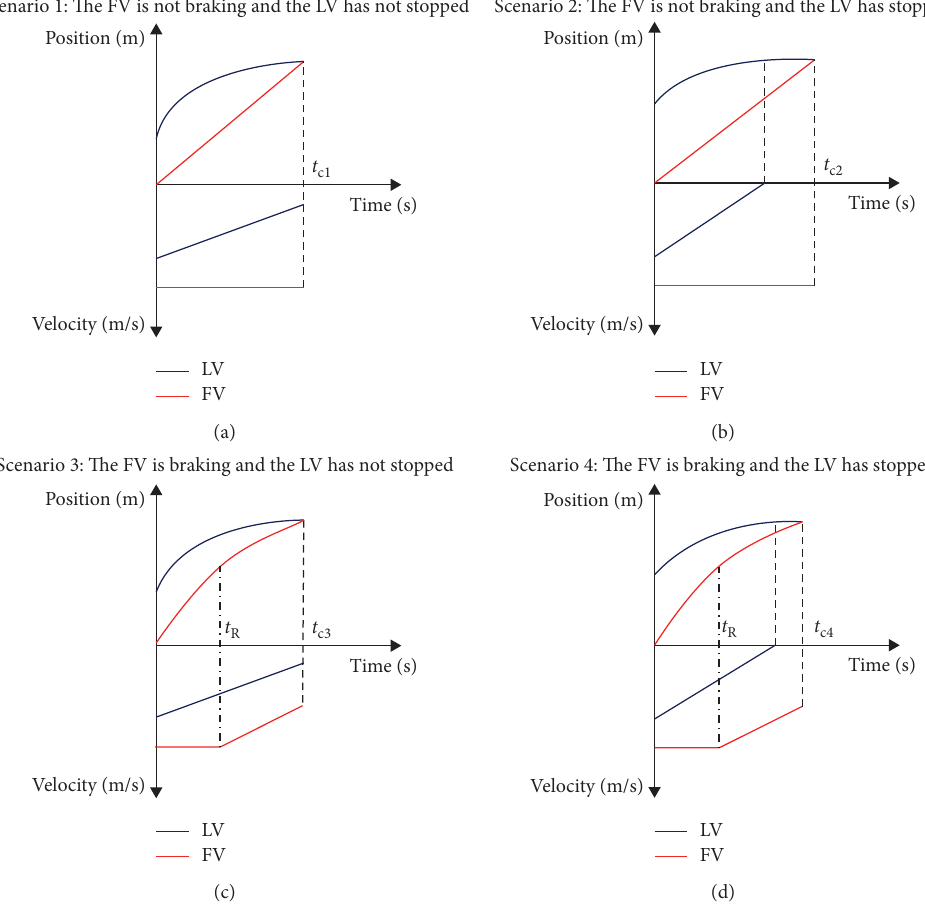
Figure 4: Descriptions of the four rear-end crash scenarios. Note . t